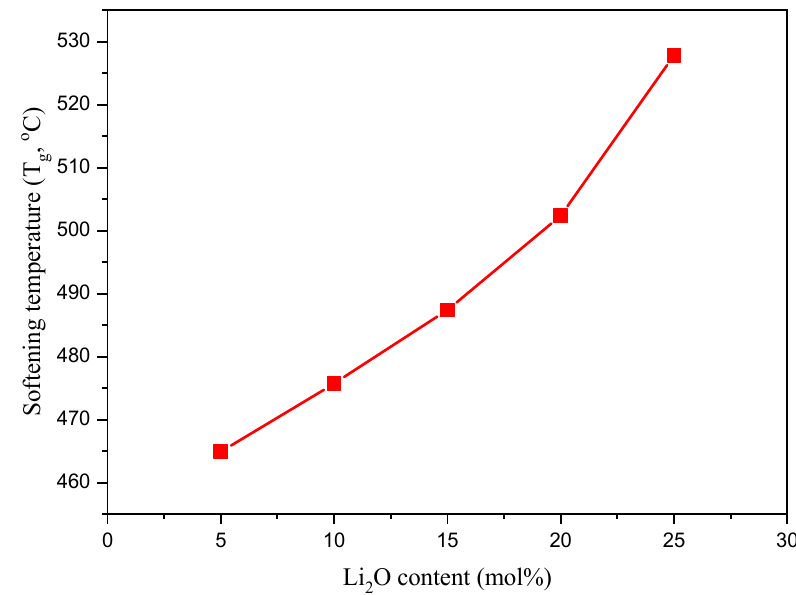
Figure 6. Variation in the softening temperature (T g ) versus the Ti 2 O insertion ratio.